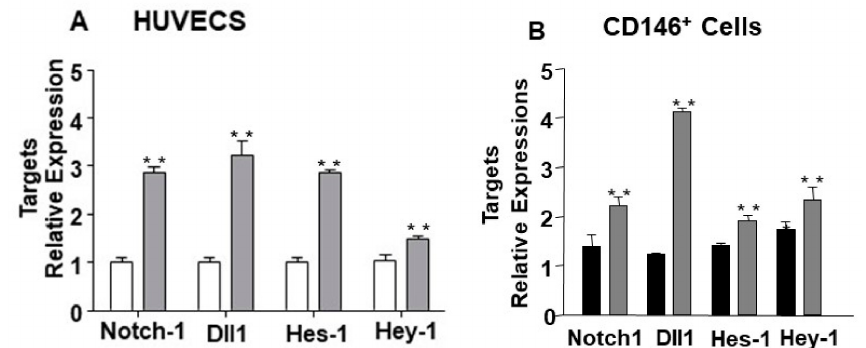
Figure 5. Impact of miR-24-3p inhibition on Notch pathway components’ miR-24-3p expression in cultured HUVECs and microvascular ECs exposed to limb ischemia. ( A ) Bar graph shows miR-24-3pNotch-1, Dll1, and down-stream targets Hes-1 and Hey-1 mRNAs in HUVEC transfected with miR-24-3p inhibitor (light grey columns) compared to control (white columns). ( B ) Bar graph shows the modulations of Notch-1, Dll1, Hes-1, and Hey-1 mRNA in CD146 positive cells isolated by ischemic adductor muscle at 3 days post-ischemia treated with in vivo miR-24-3p inhibitor (Ad. Decoy.miR-24-3p, grey bar) compared to scramble control ( Ad. Null , black bar). Gene expression was normalised to 18S. Cell experiments were performed in triplicate and repeated three times. Analyses on muscular cells were developed using n = 10 mice per group. Values are means ± SEM. ** p < 0.005 vs. the respective